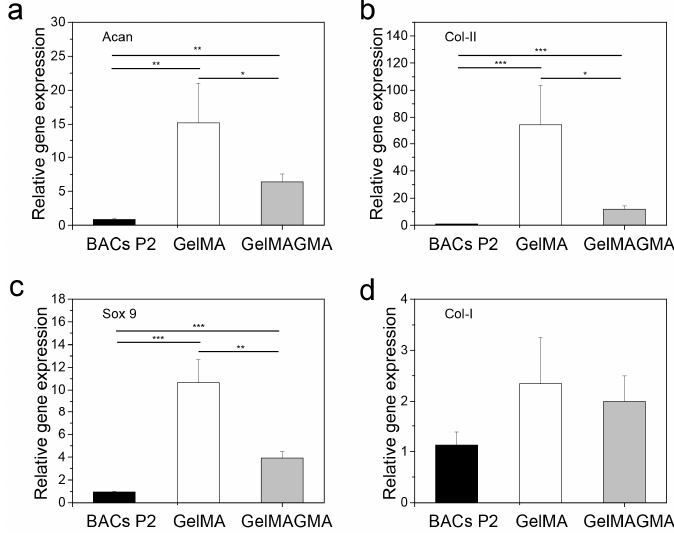
Figure 7. Expression of genes encoding aggrecan ( a ), collagen II ( b ), Sox 9 ( c ), and collagen I ( d ) of chondrocytes in GelMA and GelMAGMA hydrogel implants after six weeks of implantation. Data represent means ± SD, N = 3. * p < 0.05; ** p < 0.01; *** p < 0.005.